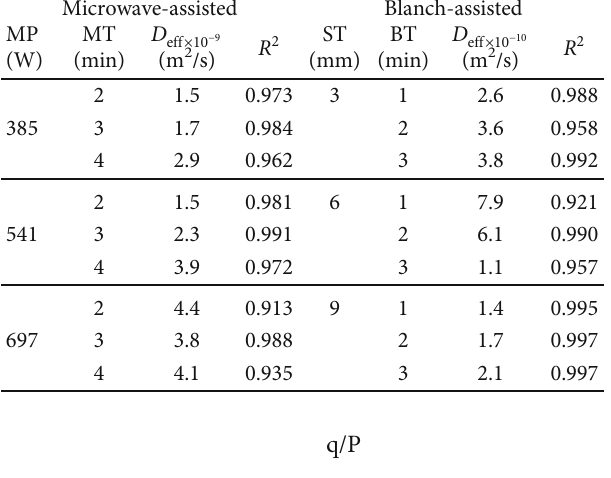
Table 2: Moisture di ff usivity for microwave and blanch assisted air drying at 70 ° C and their R 2 values. Microwave-assisted